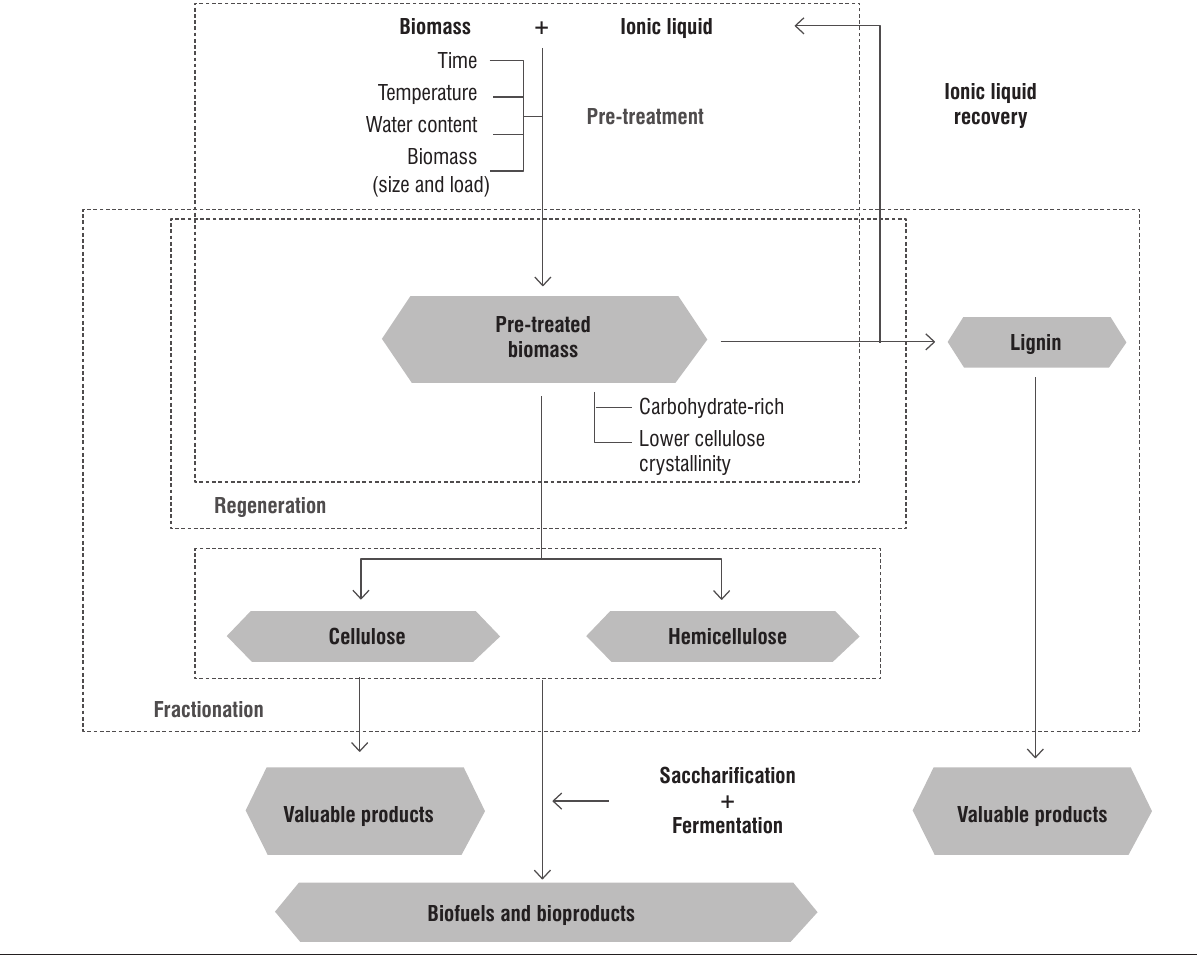
Figure 4: Ionic liquid pretreatment and fractionation in a